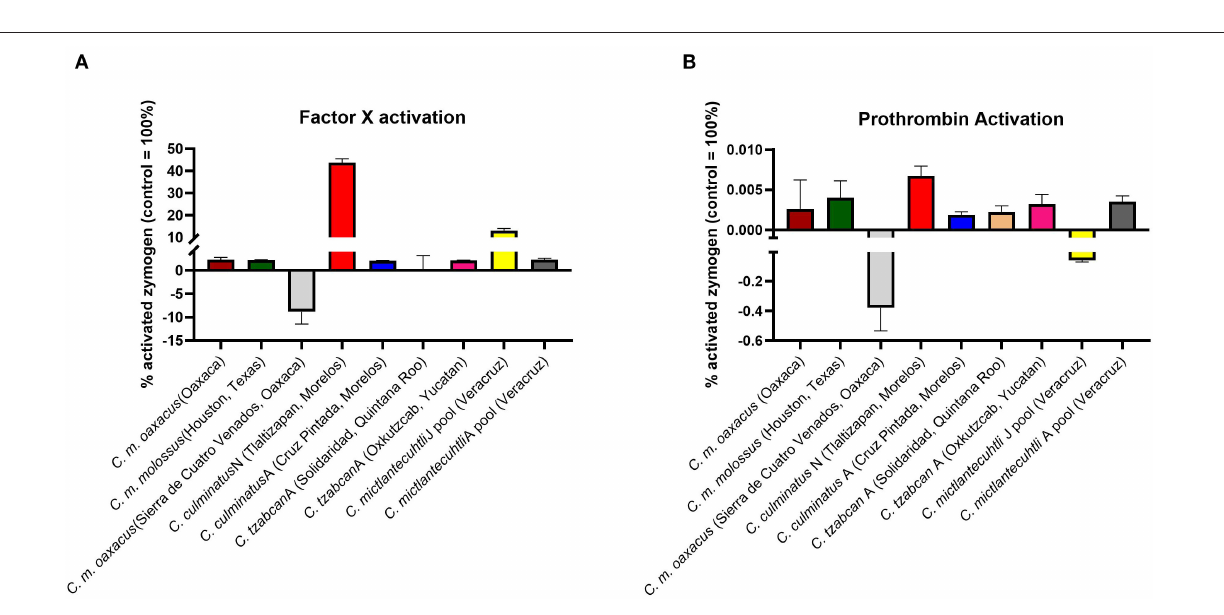
FIGURE 9 | Fluorometry graphs showing activation of FX (A) and prothrombin (B) by selected rattlesnake venoms. Activation is expressed as the relative percentage of zymogen converted to its active form against a benchmark positive control incubated with thrombin and FXa, respectively (i.e., 100% active enzyme). Note the difference in Y-axis between FX activation and prothrombin activation, indicating considerably greater potency for the former. Values are n = 3 mean ±